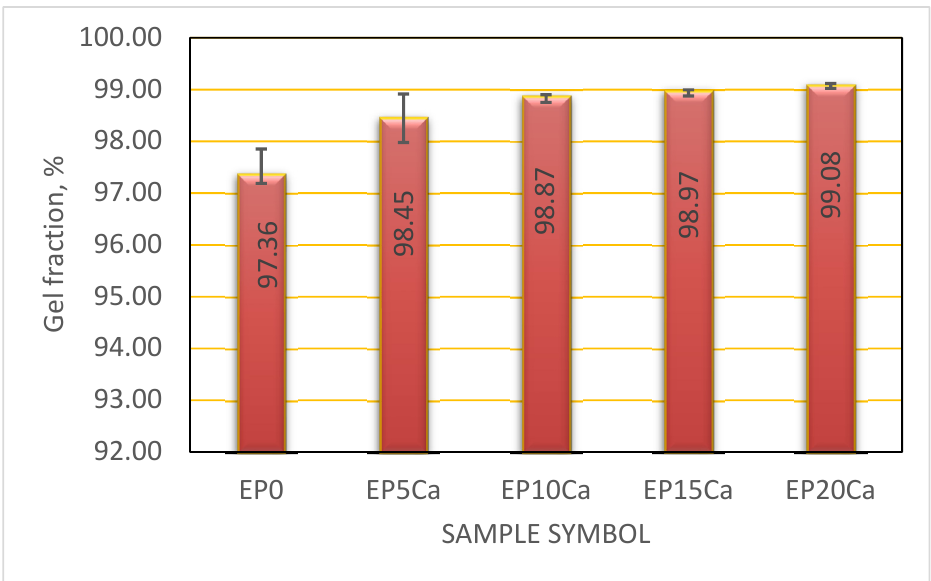
Figure 1. Variation in gel fraction as a function of hemp fiber loading.